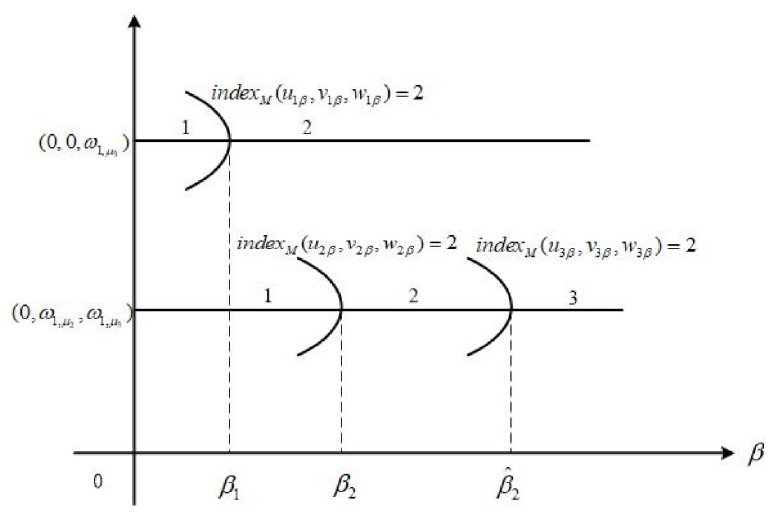
Fig. 1: Bifurcation diagram for the system (1.1) when β 1 < β 2 < ˆ β 2